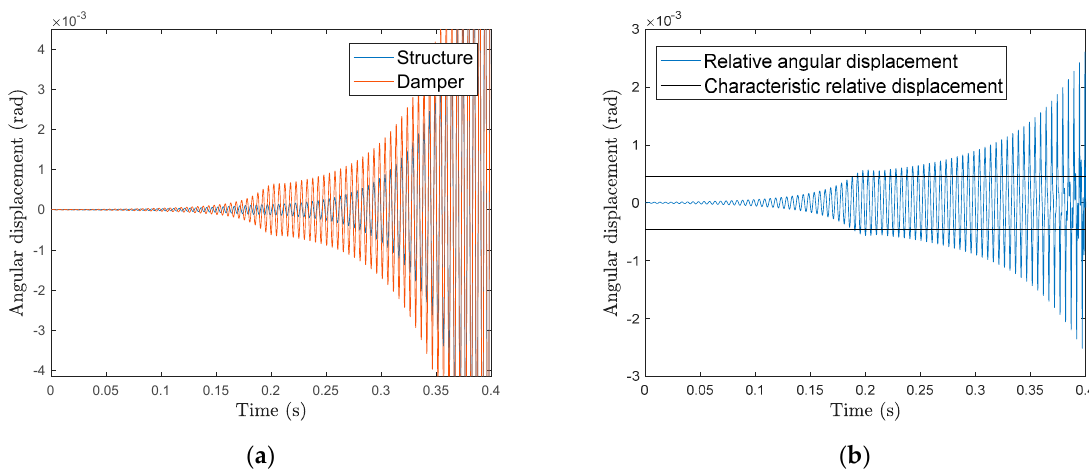
Figure 12. Time domain results for an instability of D i = − 2.1%. ( a ) Angular displacement of the drill string structure and the damper. ( b ) Relative angular displacement between the damper and the drill string structure.